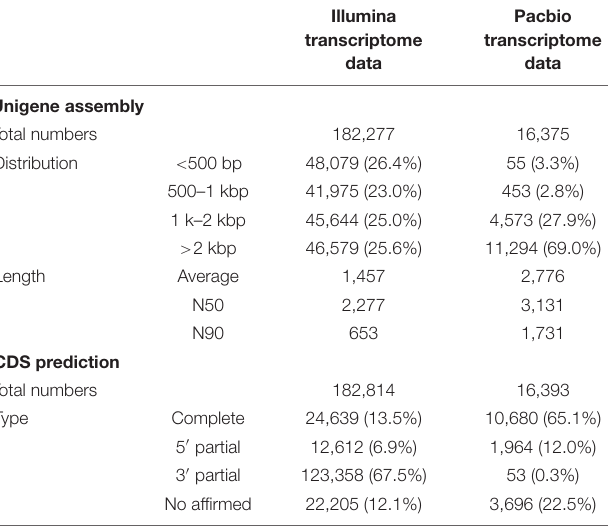
TABLE 1 | Comparison of unigene information from Illumina and Pacbio